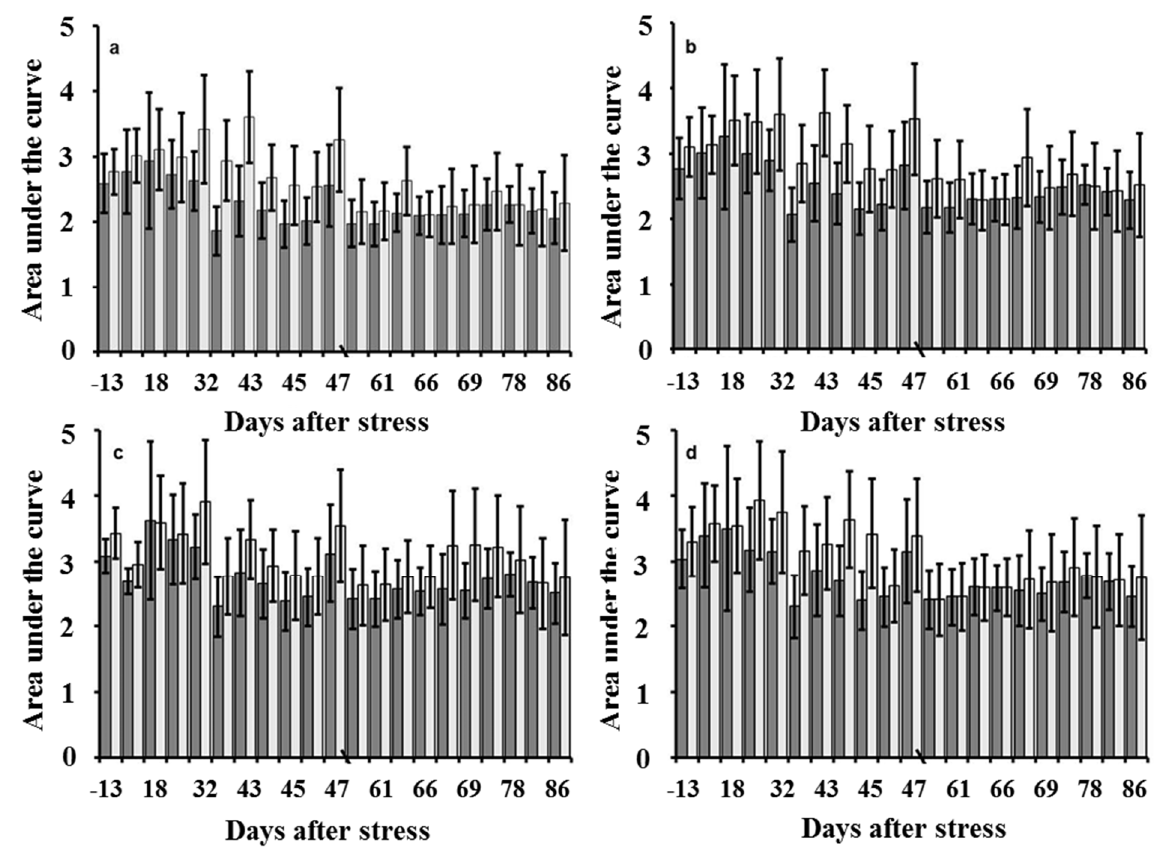
Figure 5. The mean and standard deviations of the area under the curve for SWIR regions: ( a ) 2145–2185 nm; ( b ) 2185–2225 nm; ( c ) 2235–2285 nm; and ( d ) 2295–2365 nm. The dark bars are the control group, and the light ones are the stressed treatment. Error bars are the standard deviation. The break in the horizontal axis between 47 and 52 days after stress separates the period of water stress from recovery; n = 168. Avg is the average; Sd . is the standard